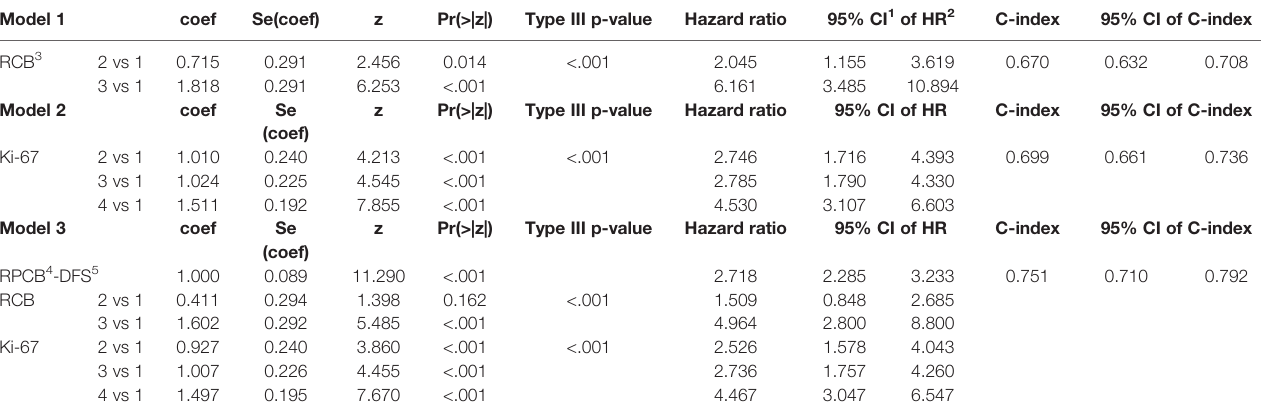
TABLE 1 | Disease free survival prediction according to RCB class, Ki-67 and RPCB model. Model 1